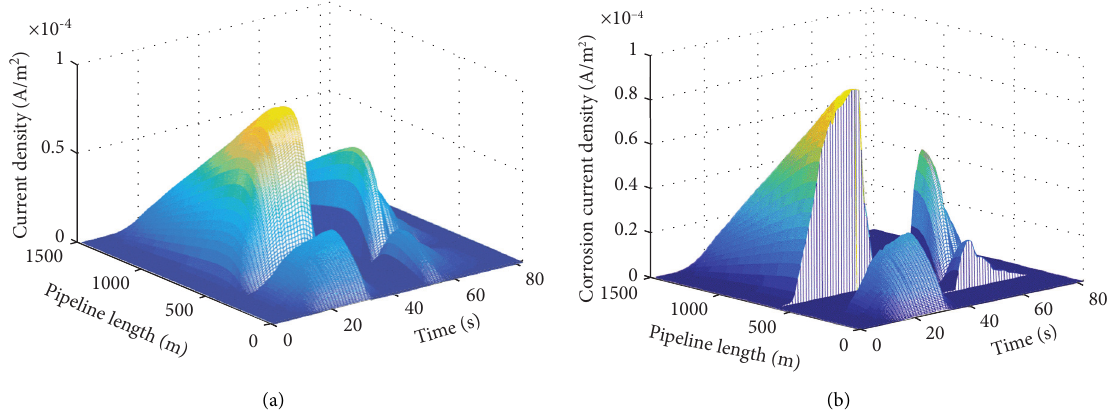
Figure 12: Distribution of current density on the pipeline in the section. (a) Leakage current density of pipeline damaged at acceleration. (b) Corrosion current density of pipeline damaged at